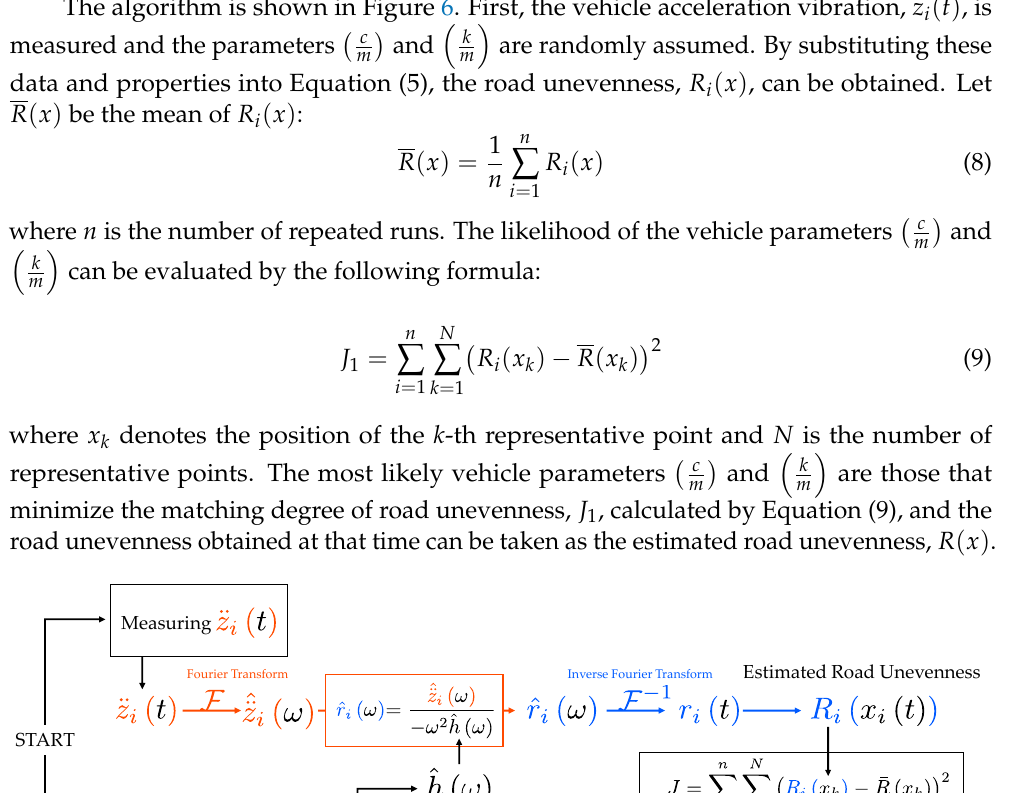
(cid:16) (cid:17) (cid:0) c (cid:1) k and m m